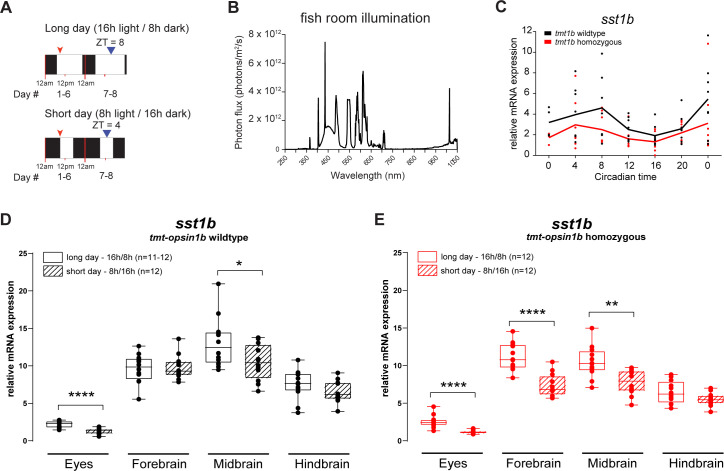
tmt-opsin1b sensitizes sst1b regulation to changes in photoperiod.(A) Schematic representation of the 2 different photoperiods assigned to different cohorts of tmt-opsin1b wild-type and tmt-opsin1b mutant adult fish. Black boxes: dark period; white boxes: white light period. Red arrowheads: feeding time; blue arrowheads: time when fish were sacrificed and the brain dissections made. (B) Light spectrum of the light used in (A). (C) Relative mRNA expression of sst1b in tmt-opsin1b (tmt1b) wild-type and mutant larvae sampled during constant darkness after entraining with 16 h/8 h white light/dark cycle at 27°C. (D, E) sst1b mRNA transcript expression levels in tmt-opsin1b wild-type (D) and tmt-opsin1b homozygous mutant (E) relatives. ****P ≤ 0.0001, **P ≤ 0.01, *P ≤ 0.05. Box plots: single bar: median; box: first and third quartile; whiskers: minimum and maximum. Each data point represents 1 biological replicate. Metadata: S6 Data. For further details on spectra: S3 Fig.